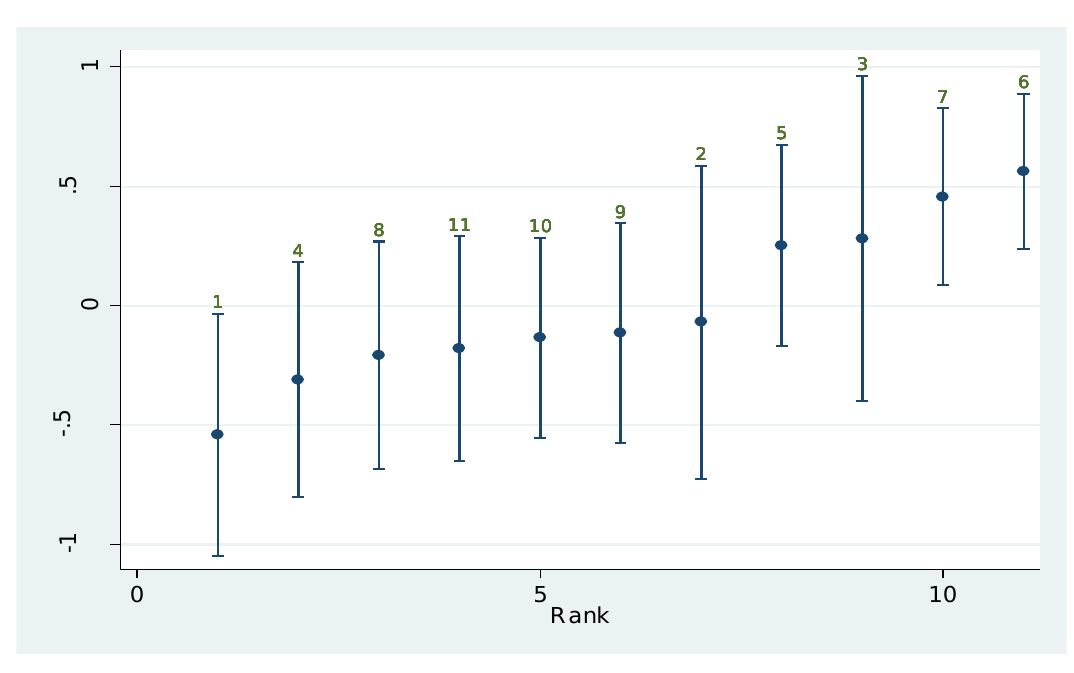
Figure 4. The technical efficiency for the considered